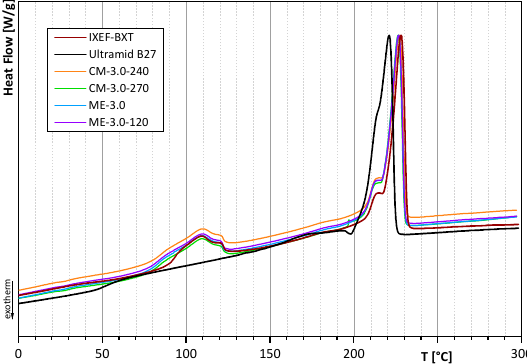
Figure 6. DSC curves of the second heating cycle of untreated polymers and of films with 3.0 wt.-% filler.